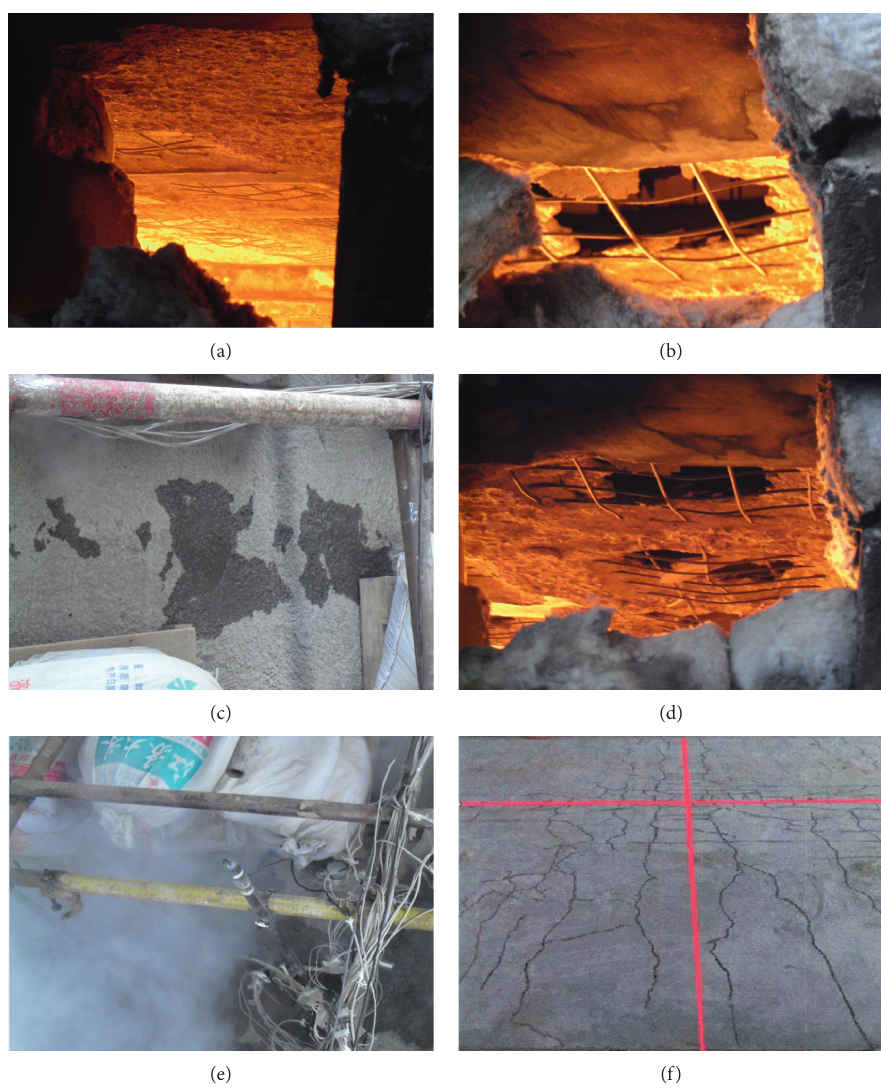
Figure 10: Photograph of the test slabs during the fire test at (a) 13 minutes, (b) 24 minutes, (c) 36 minutes, (d) 44 minutes, (e) 69 minutes, and (f) 119